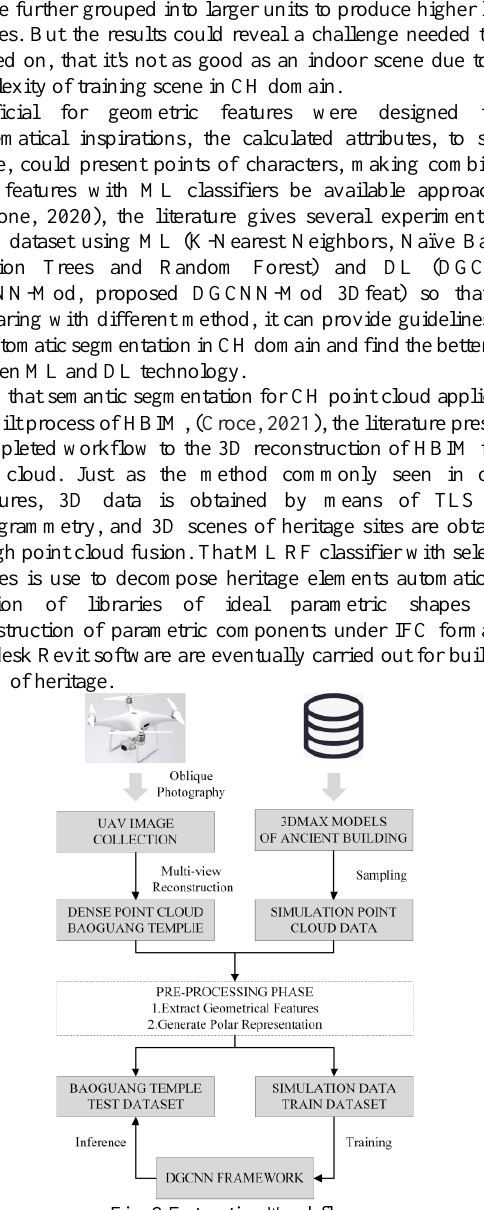
Fig. 2 Extraction Workflow